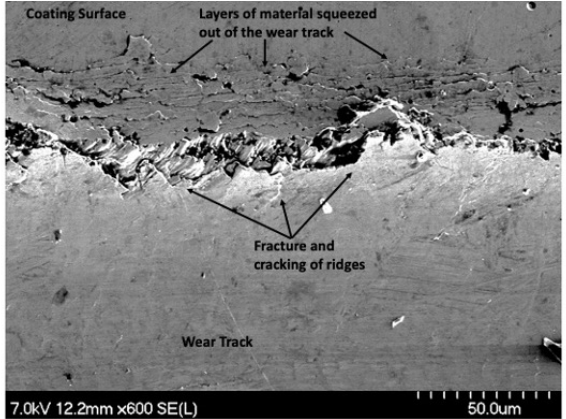
Figure 27. SEM Image of Material Layers on the 100 Pass Wear Track on the 4 μ m Thick Ni-P-NiTi Coating.